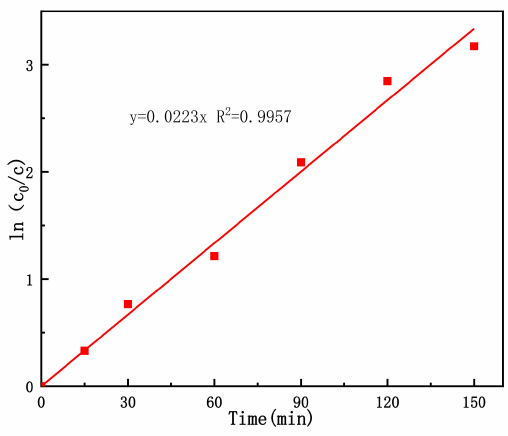
Figure 13. Kinetical plots of 3-CP degradation in optimum condition.